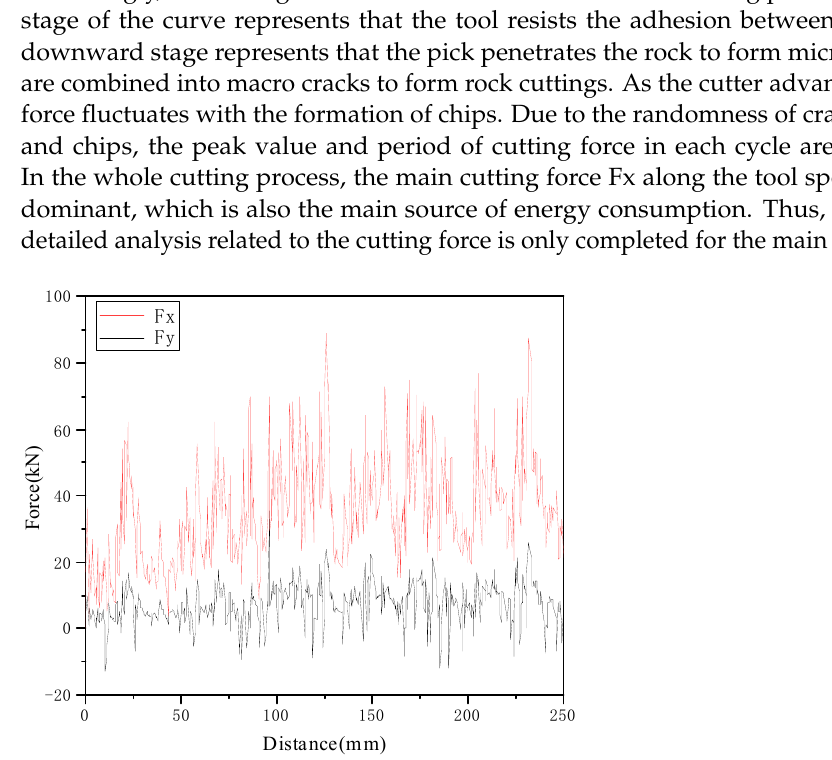
Figure 11. A typical cutting force history (ambient pressure of 10 MPa).